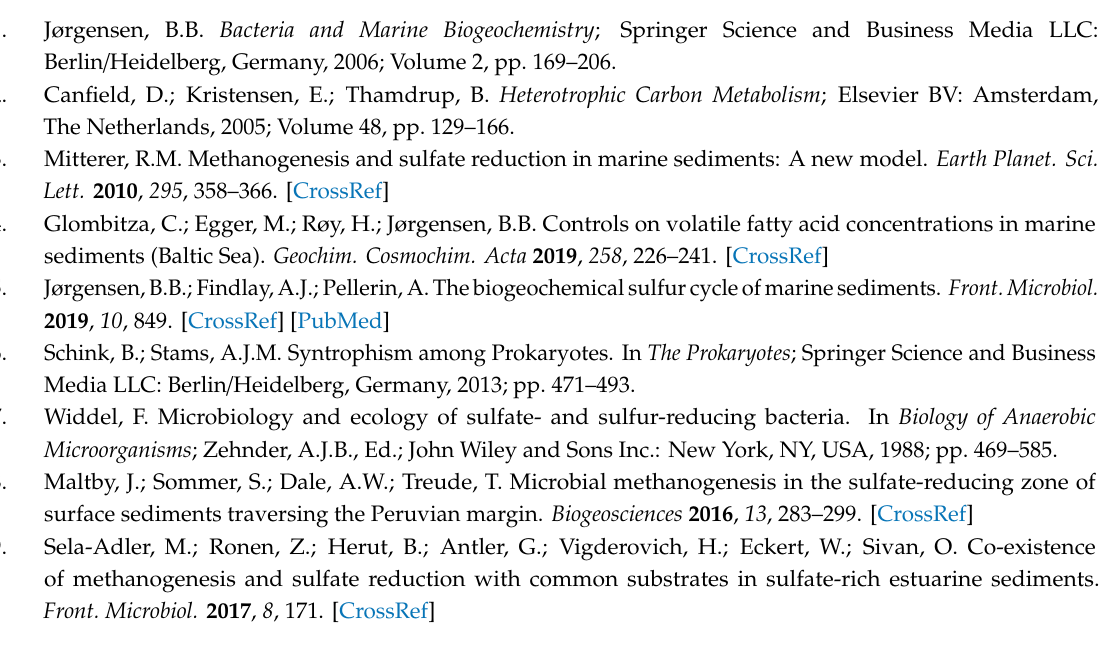
Table S1: Overview of reactions examined in this study, Table S2: Overview of all the enrichment slurries fed with butyrate and the total amounts of the reactants consumed and products formed during the enrichment period, Table S3: The number of reads per sample generated by Pyrosequencing for Bacteria and HiSeq Illumina sequencing for Archaea, Table S4: Relative abundance (HPLC / MS mass chromatogram area, summed by IPL head group per gram sediment dry weight) of all IPLs identified in Aarhus Bay sediment and the enrichment slurries inoculated with this sediment, Figure S1: Depth profiles of sediment pore water sulfate, sulfide, and methane for Station M1, in Aarhus Bay, Denmark, Figure S2: Relative abundance of the bacteria in all slurries and environmental samples at family level, Figure S3: Heatmap representing the correlation between bacterial orders present at a relative abundance > 1% of total reads across the 12 slurry samples analyzed and experimental parameters, Figure S4: Relative abundance of the Archaea in all slurries and environmental samples at family level, Figure S5: Heatmap showing the correlation between archaeal families present at a relative abundance > 1% of total reads across the 12 slurry samples analyzed and experimental parameters, Figure S6: Percent relative abundance of IPLs in all enrichment slurries and environmental samples used for molecular analysis, Figure S7: Percent relative abundance of IPLs in all methane zone enrichment slurries, Figure S8: Canonical correspondence analysis of intact polar lipid (IPL) distribution, bacterial taxa distribution, and growth conditions for all enrichment